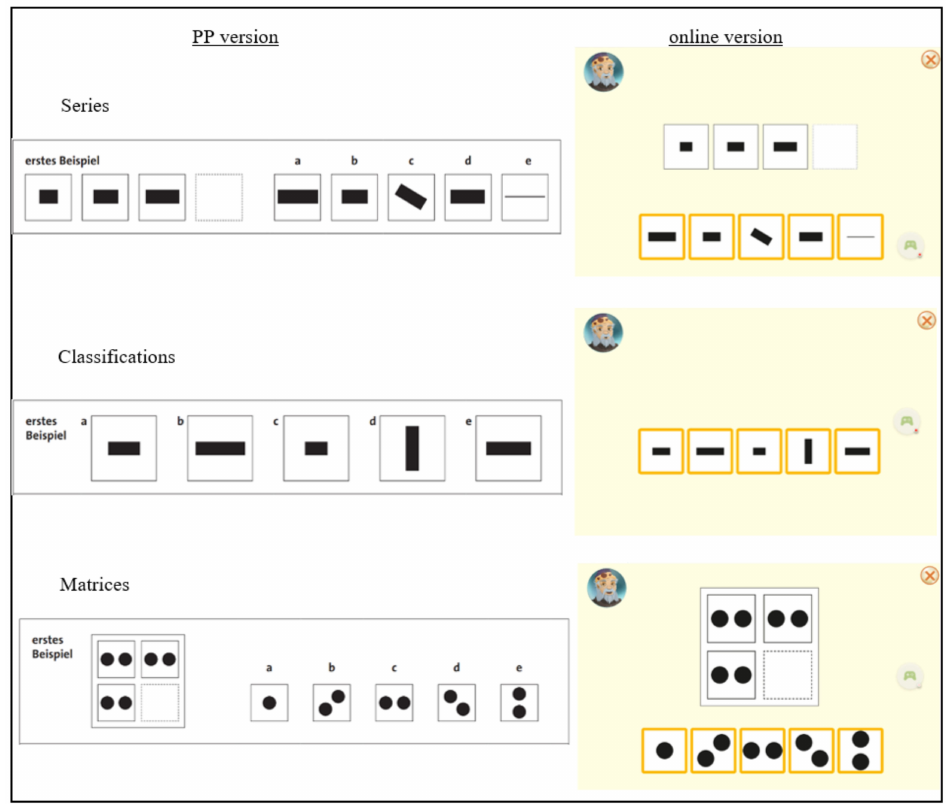
Figure 1. Comparison of the Paper-Pencil (PP) and online version of the CFT 20-R. “erstes Beispiel” =